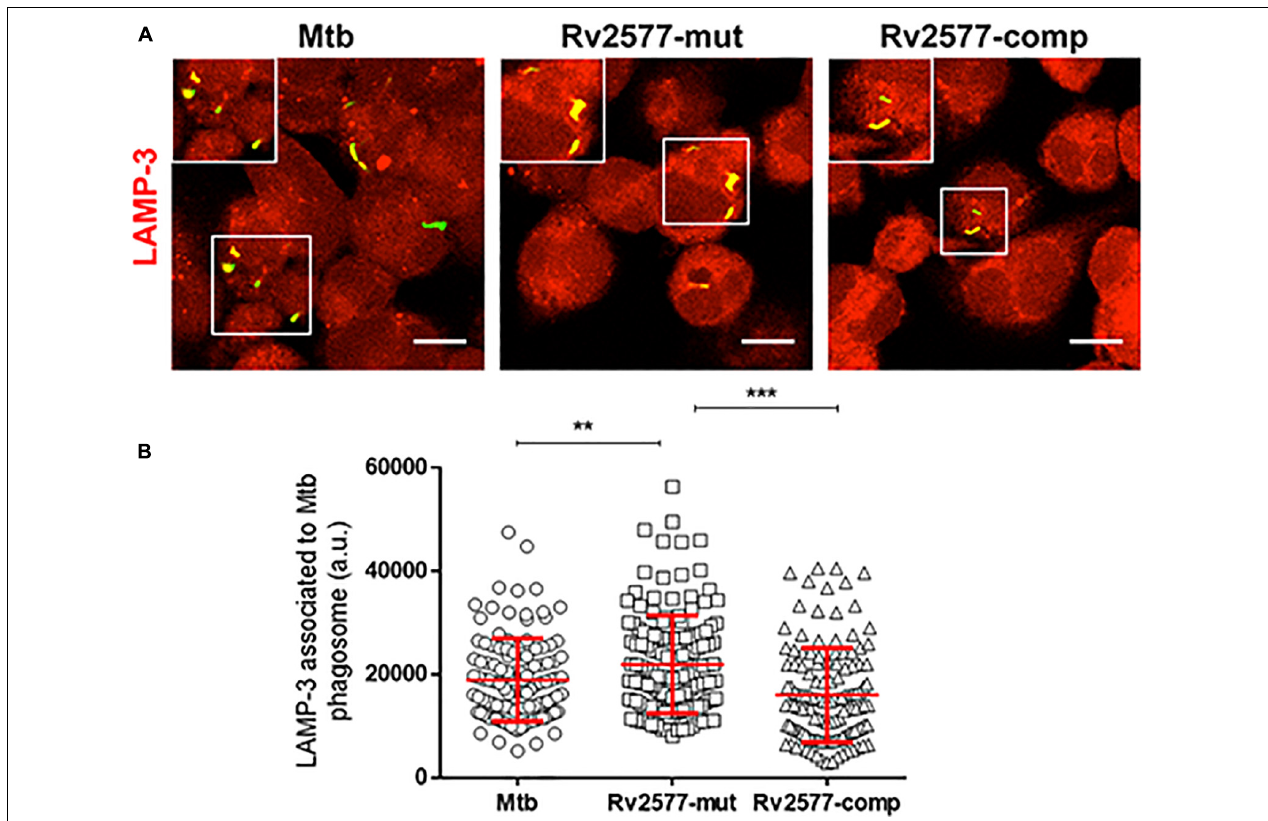
FIGURE 3 | Rv2577 participates in the arrest of human phagosome maturation. (A) Human THP-1 macrophages were infected with M. tuberculosis wild type (Mtb), the Rv2577 mutant (Rv2577-mut) and the complemented (Rv2577-comp) strains to analyze the intracellular trafficking. The bacteria were labeled with FITC (green) and the LAMP-3 protein was detected using a specific antibody (red). (B) Quantification of the fluorescence observed in (A) (association of LAMP-3 to the mycobacterial compartment). The data are based on a representative experiment of three independent experiments, all performed in duplicate. *** p < 0.001, ** p < 0.01 statistical analysis using ANOVA. Number of counted phagosomes = 150 from at least 50 different